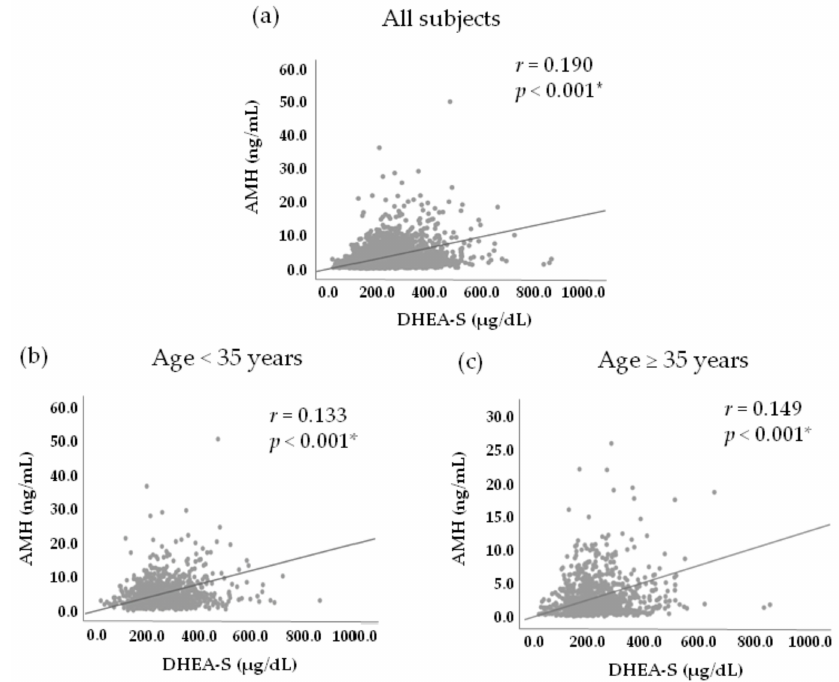
Figure 1. Correlations between serum DHEA-S and AMH levels. A weak positive correlation was observed for ( a ) all subjects; ( b ) age < 35 years; ( c ) age ≥ 35 years. * The p -value was generated using Pearson correlation coefficient.